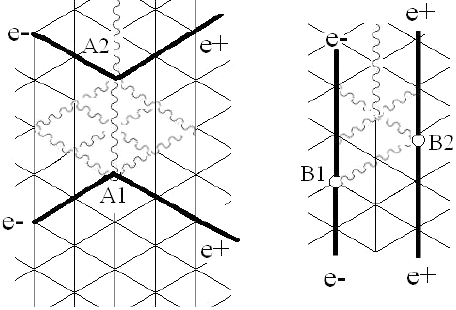
Fig. 9. Split/combine points mapped to